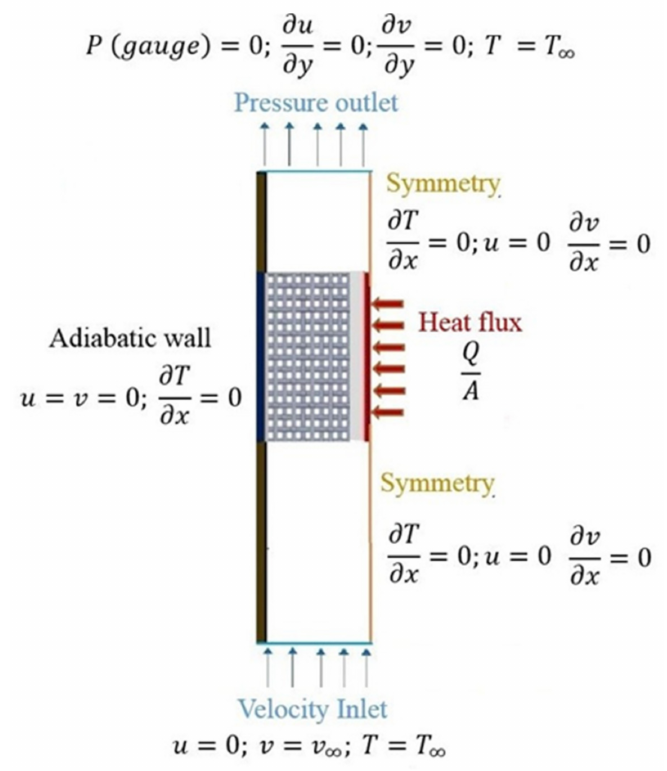
Figure 12. Sketch of numerical domain adopted in the current